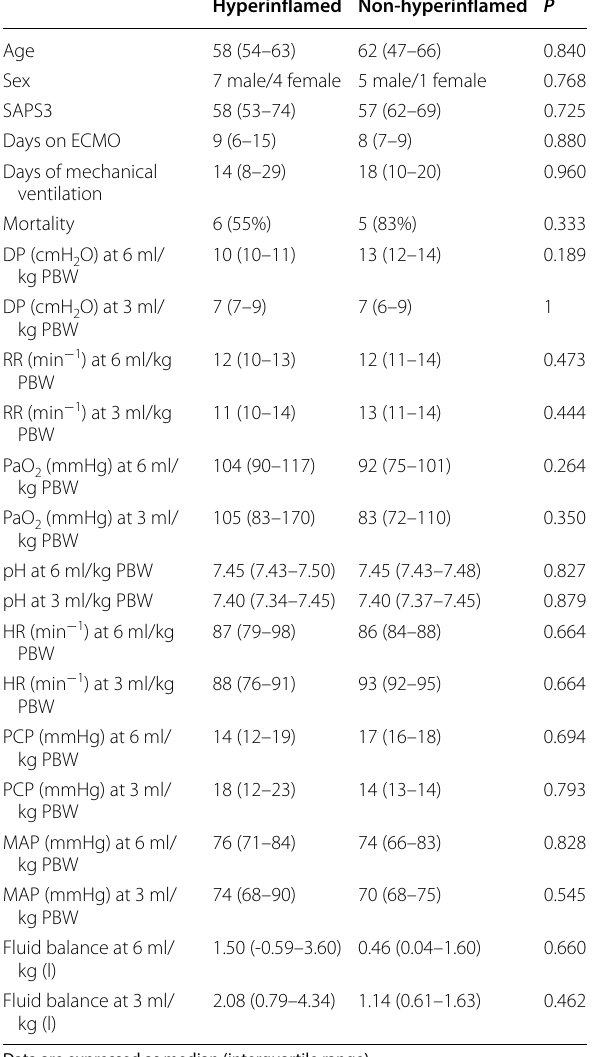
Table 2 Comparison between patients with and without a hyperinflammatory subtype (defined as a IL‑6 level in bronchoalveolar lavage fluid above 680 pg/ml during